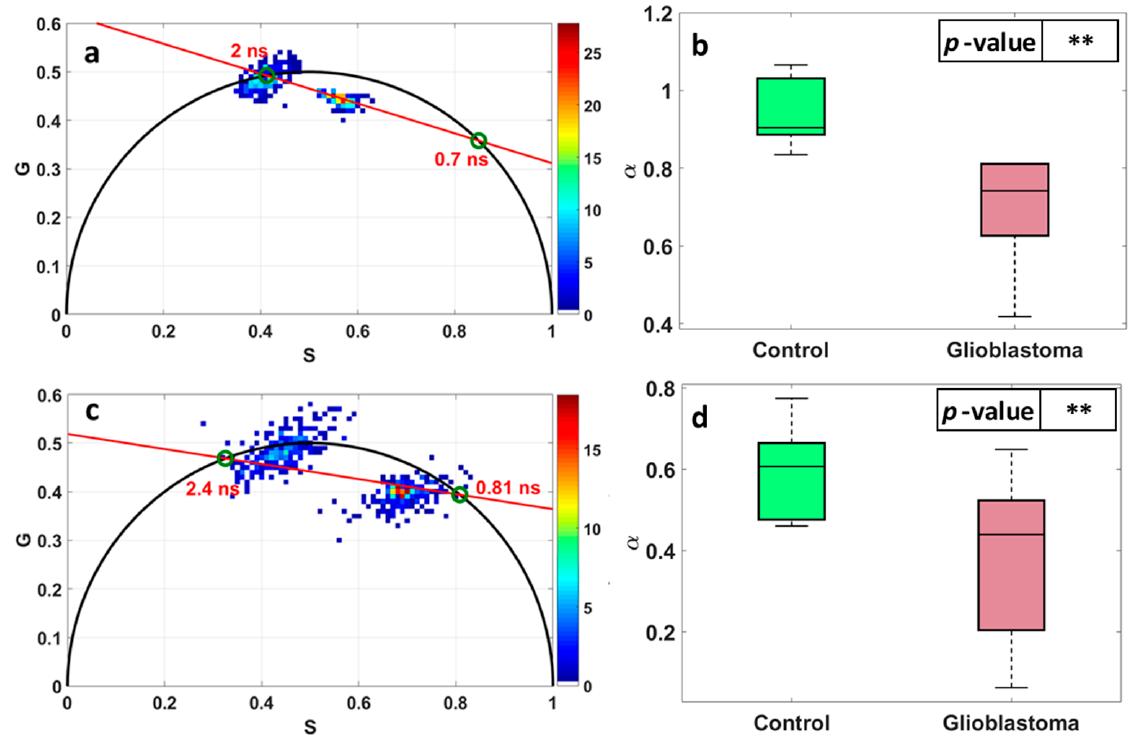
Figure 3. Fluorescence lifetime imaging (FLIM) histogram represented using the phasor approach applied to FAD ( a ) and NADH ( c ). S and G are the coordinates of each phasor count, calculated through equations 1 and 2. Repartition of the long lifetime contribution α of FAD ( b ) and NADH ( d ) for each tissue type. **: indicates that p -value < 0.05.